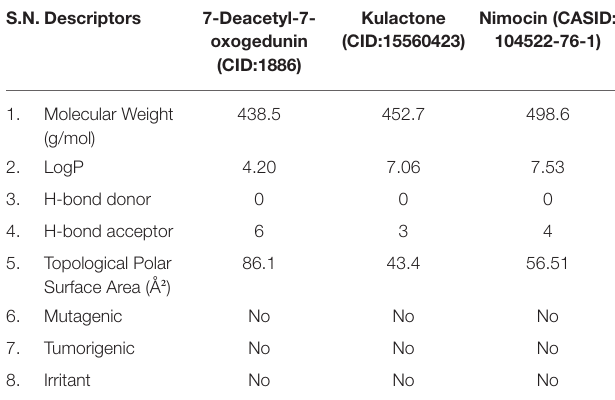
TABLE 2 | Physicochemical properties and drug-likeness of identified multi-target phytochemicals.